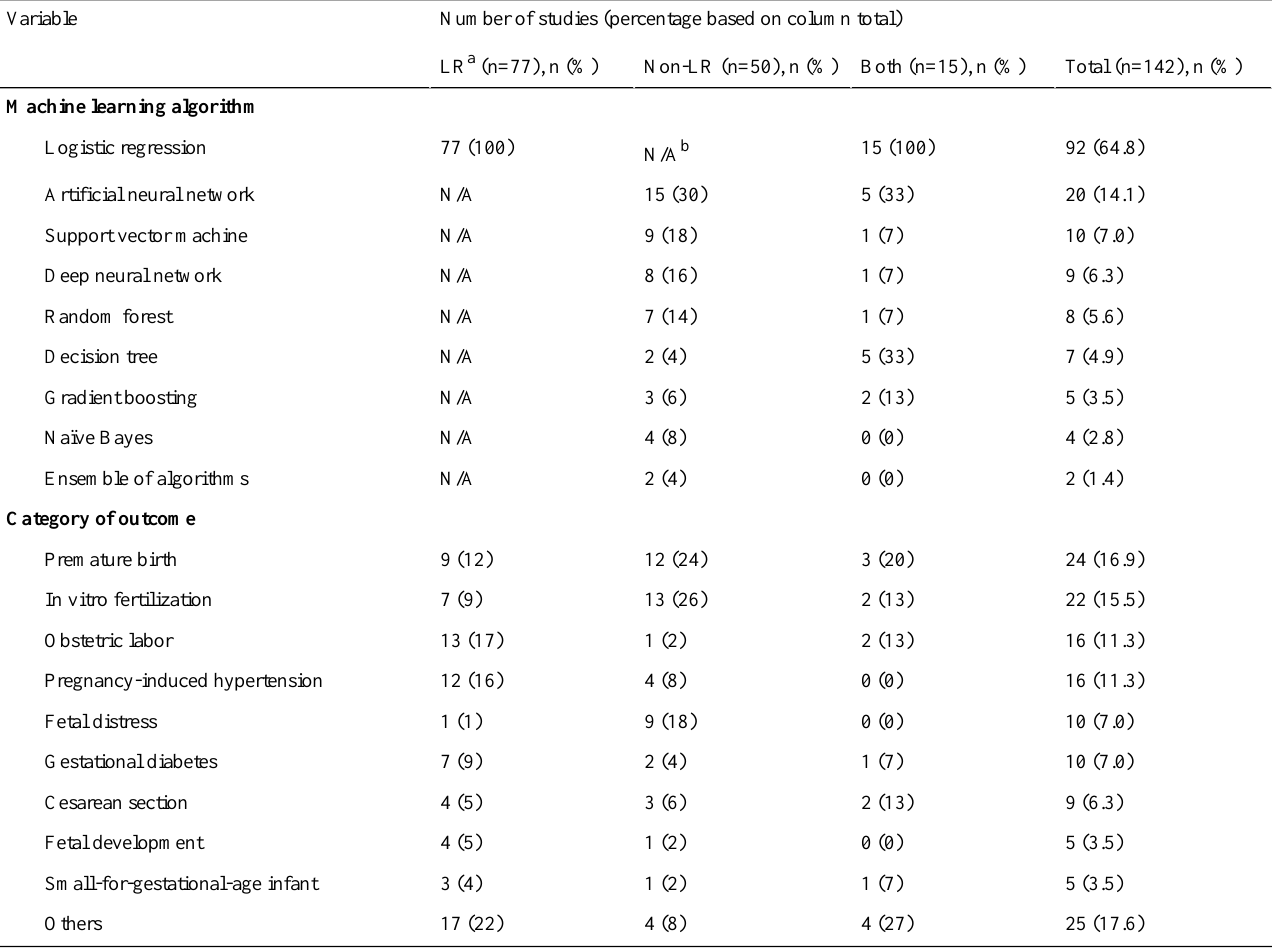
Table 2. Machine learning algorithm and category of outcome. Number of studies (percentage based on column total)Variable